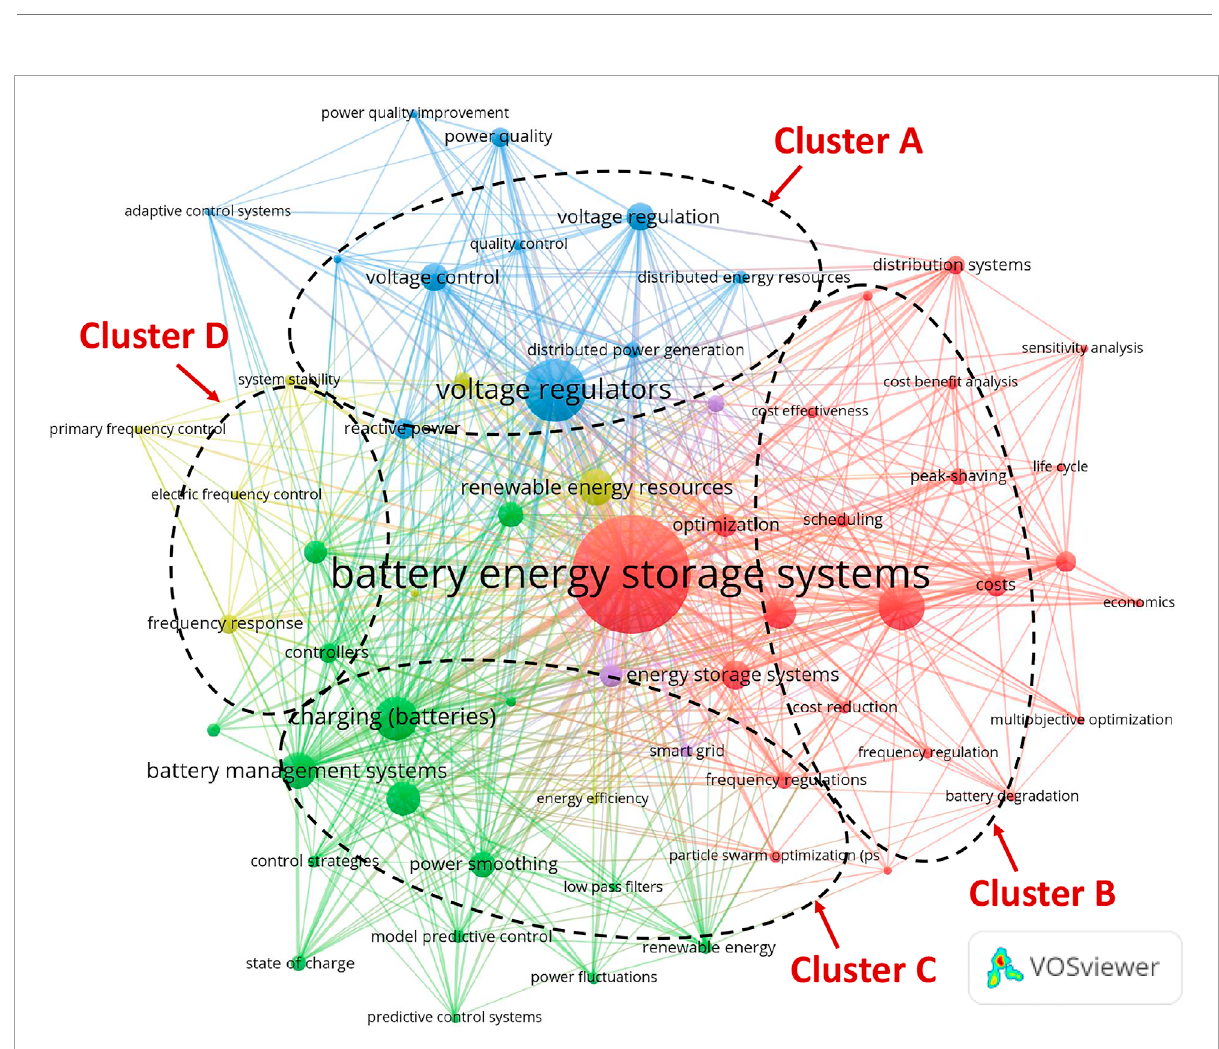
FIGURE 2 Research themes emerged from vosviewer